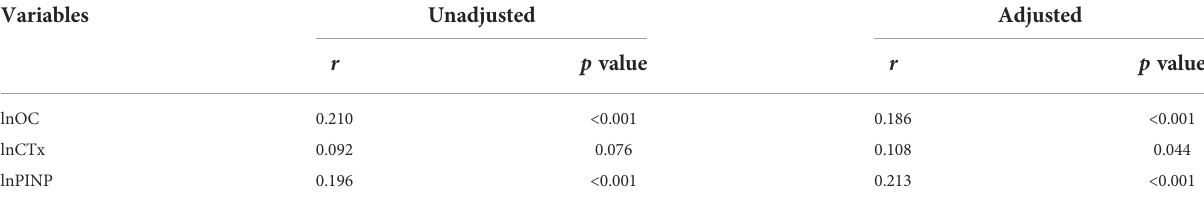
TABLE 2 Associations between serum sodium levels and BTMs.